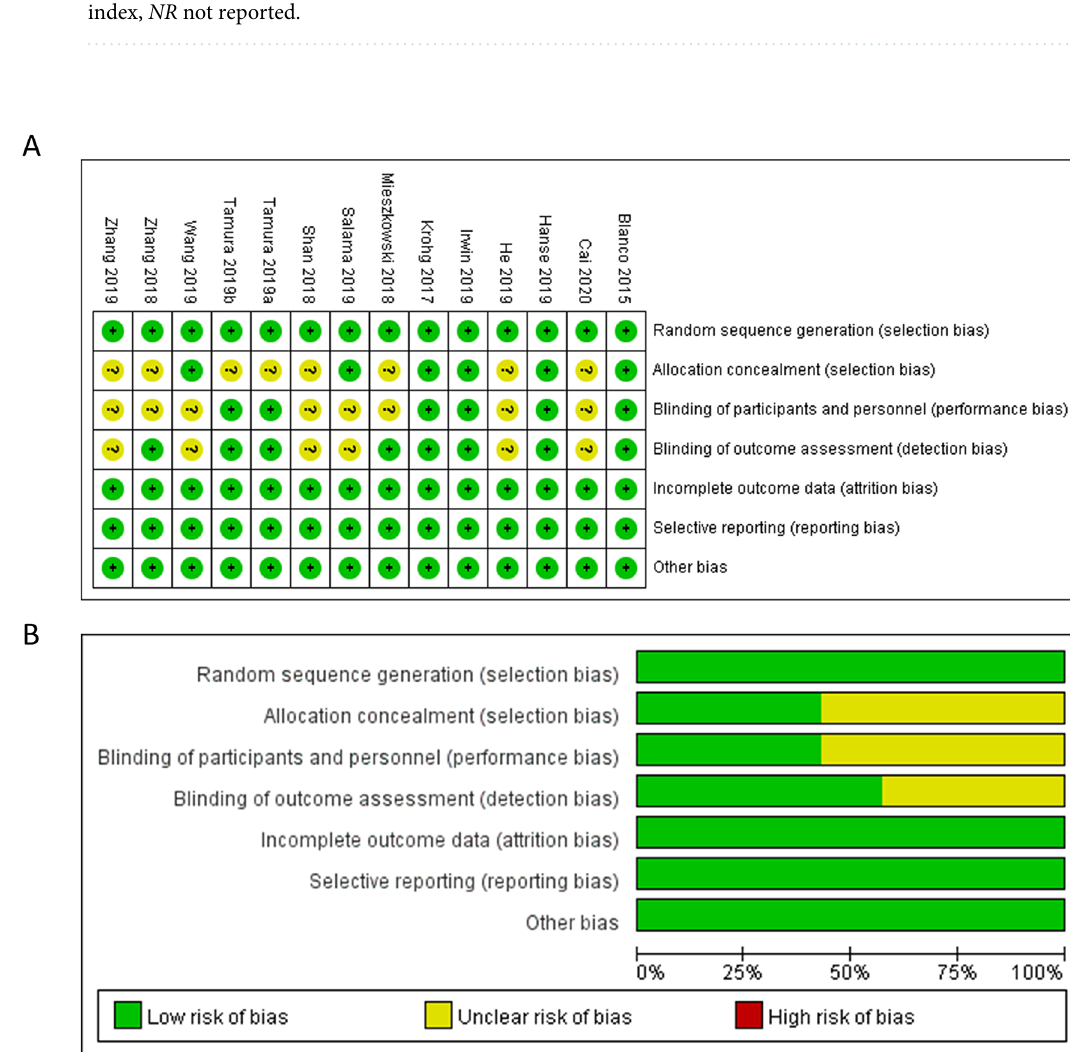
Table 1. Characteristics of included studies. QLB quadratus lumborum block, CON control, BMI body mass index, NR not reported.